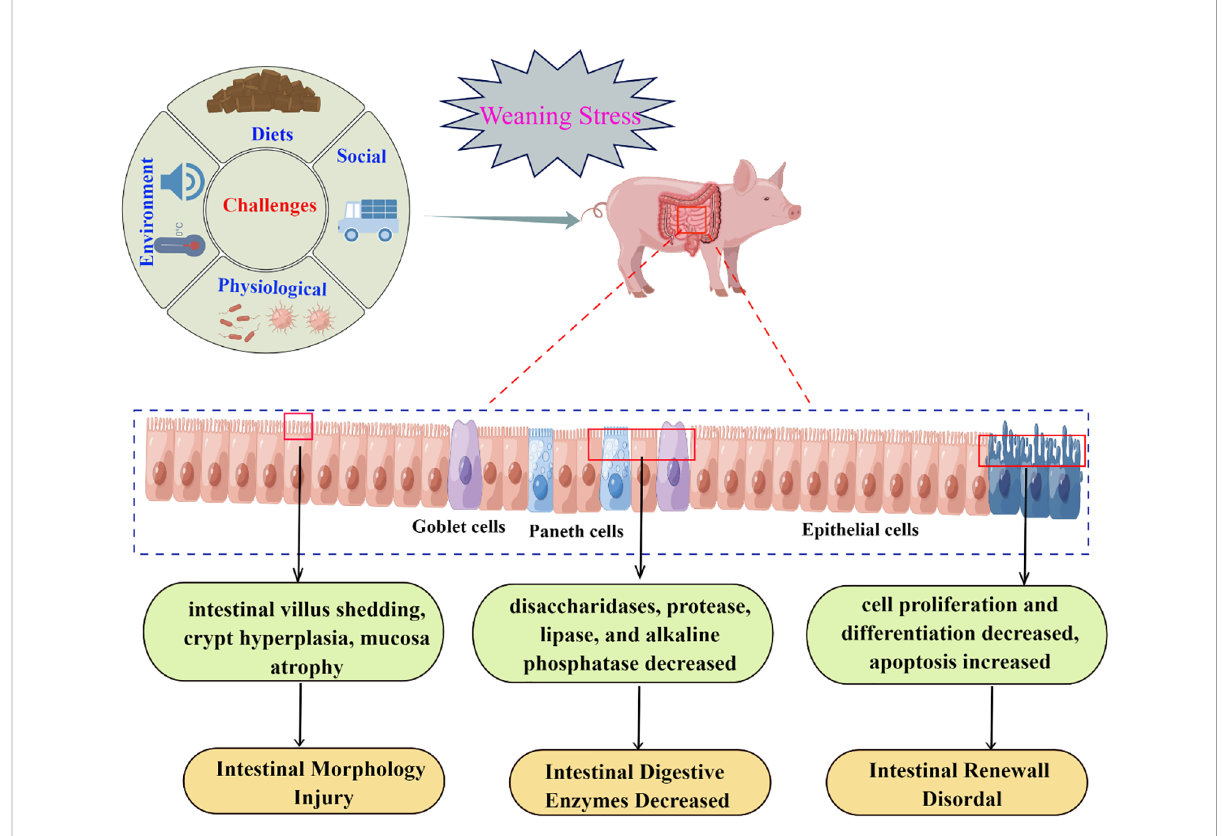
FIGURE 1 Relationship between weaning stress and intestinal development (By